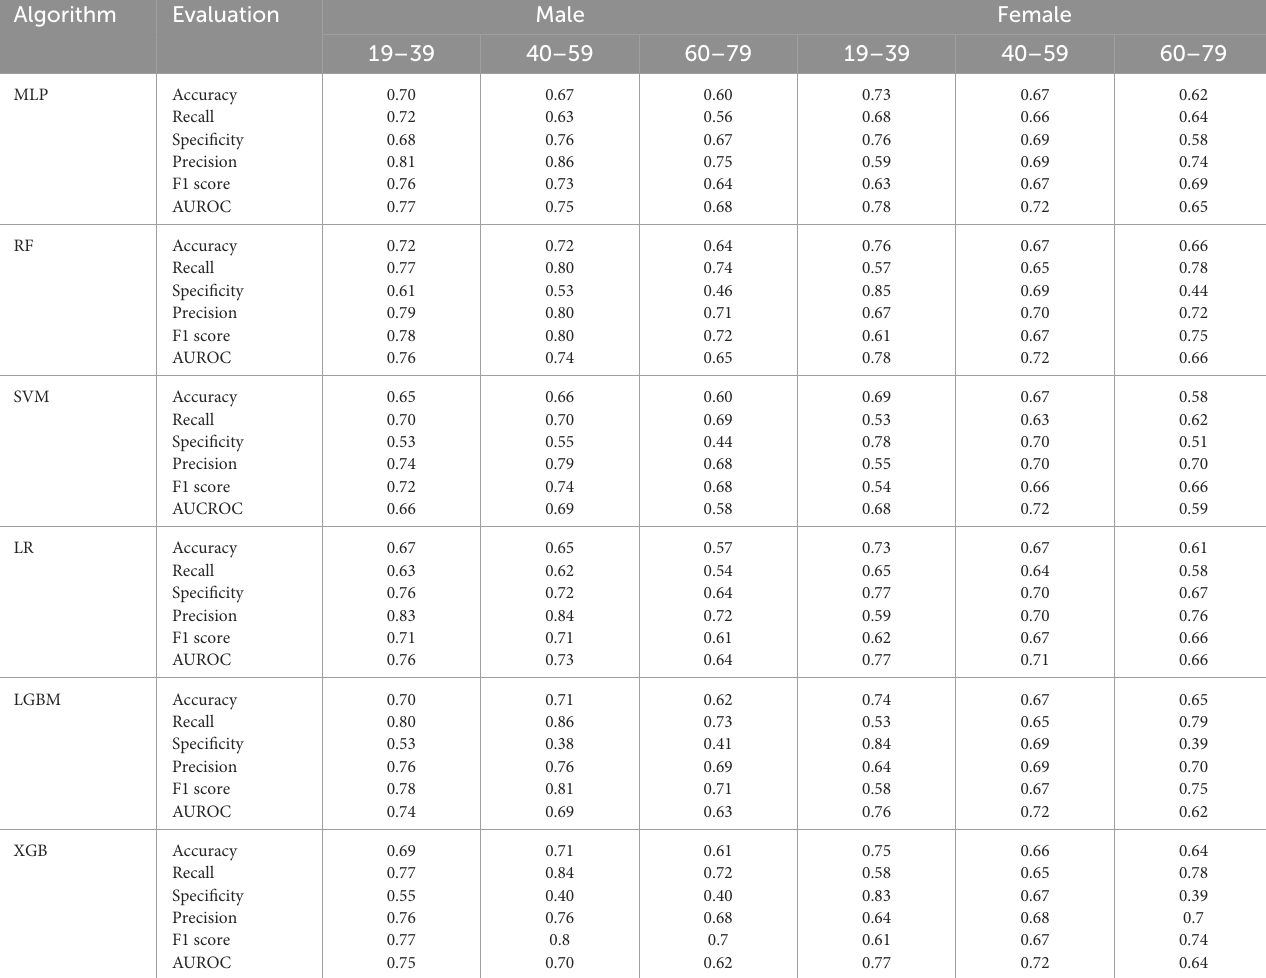
TABLE 5 Metric-wise performance of all classifiers used for each gender and age group.